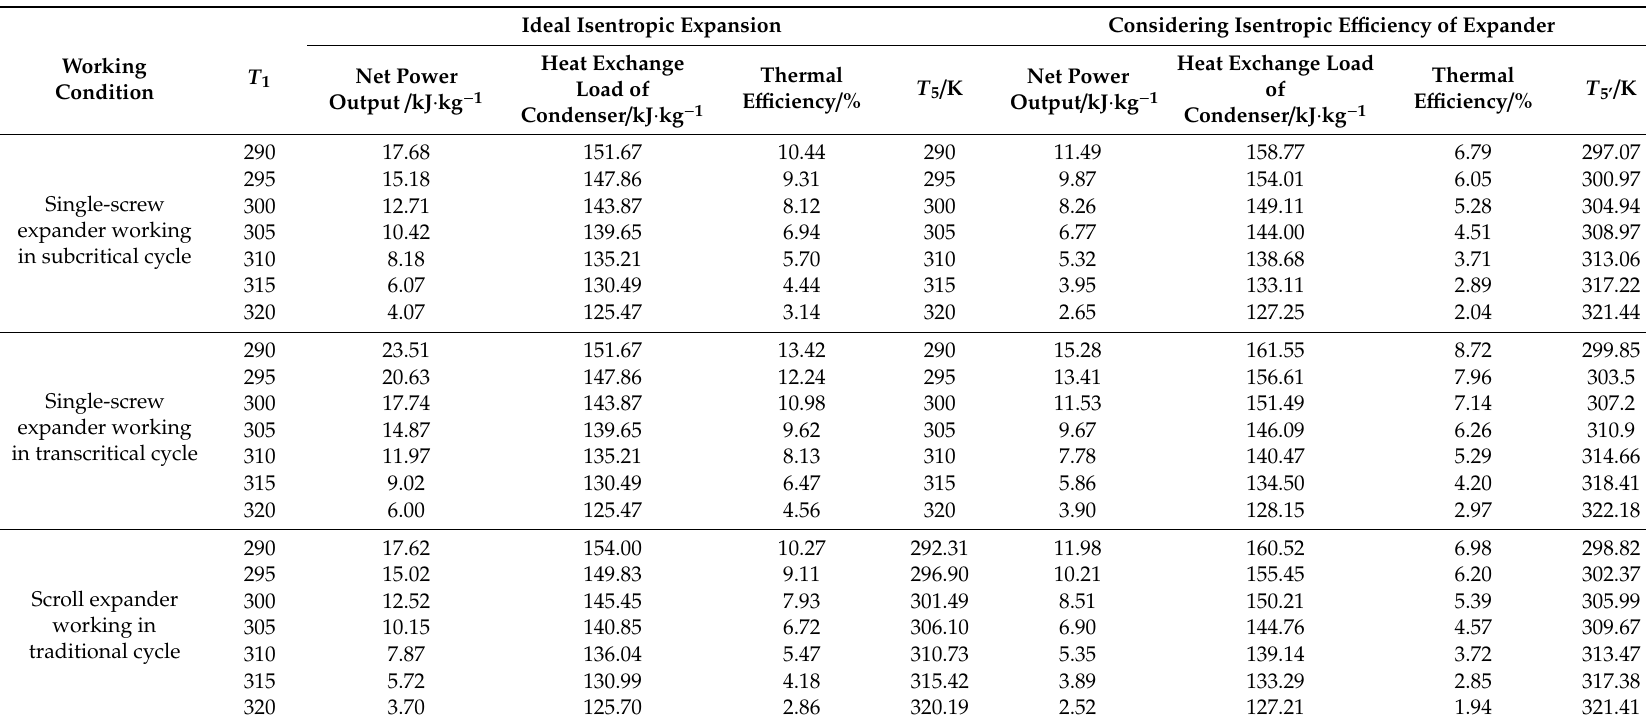
Table 7. Comparison of the thermodynamic performance of R1234yf with and without consideration of the isentropic e ffi ciency of the